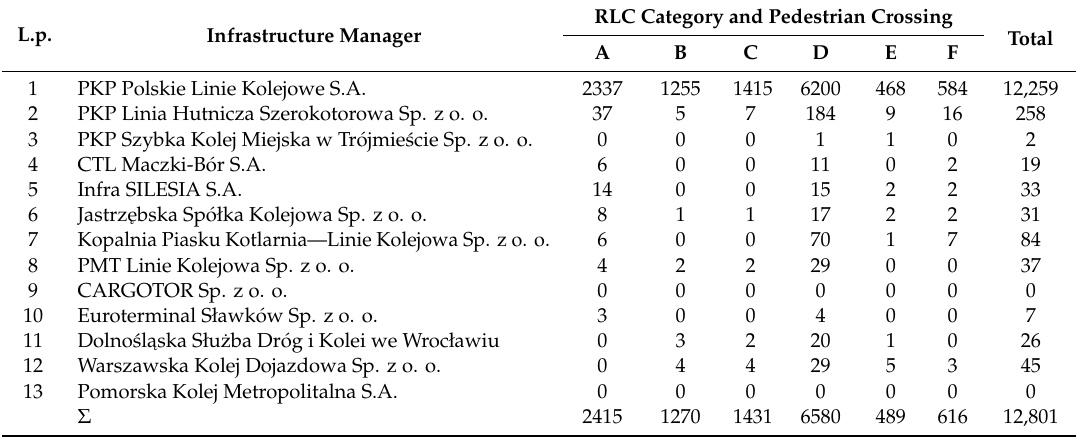
Table 2. Number of Railway level crossings (RLCs) and crossings of individual administrators. L.p. Infrastructure